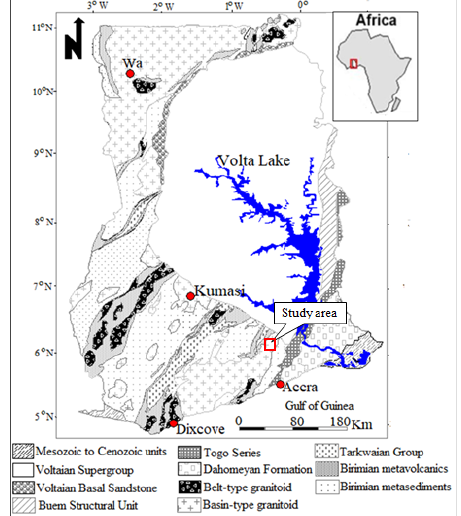
Sketch of Geological map of Ghana showing study area 2.2 Sampling design